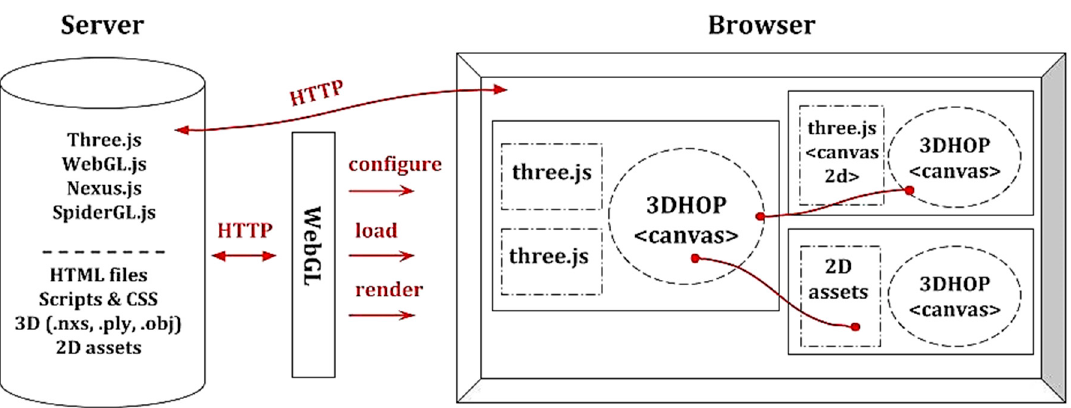
Figure 3. System architecture and functional relationships that accomplish the server–client computing